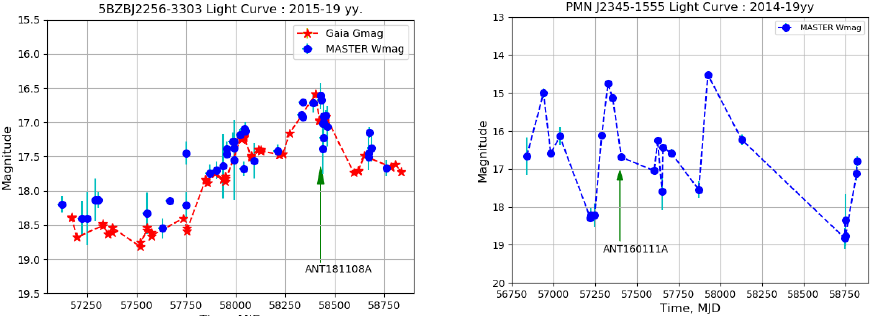
Figure 16. Optical variability of the blazars 5BZBJ2256-3303 and PMN_J2345-1555 according to the MASTER data (and Gaia for left one). The arrow indicates HE ANTARES neutrino event ANT181108A ( left ) and ANT160111A ( right ).